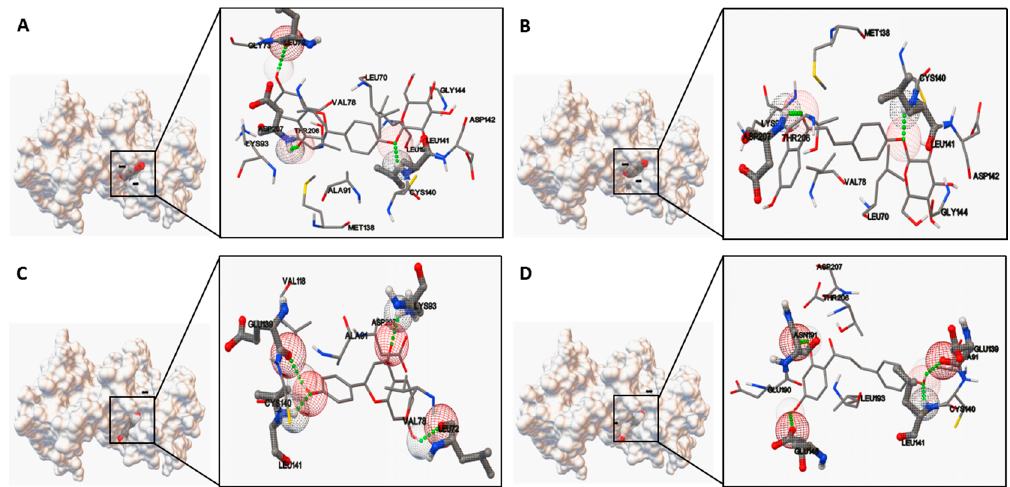
Figure 7. Ligand interaction and comparative binding sites diagrams of the potent ATP competitive inhibitors of MK2: ( A ) liquiritin; ( B ) isoliquiritin; ( C ) liquiritigenin and ( D ) isoliquiritigenin.